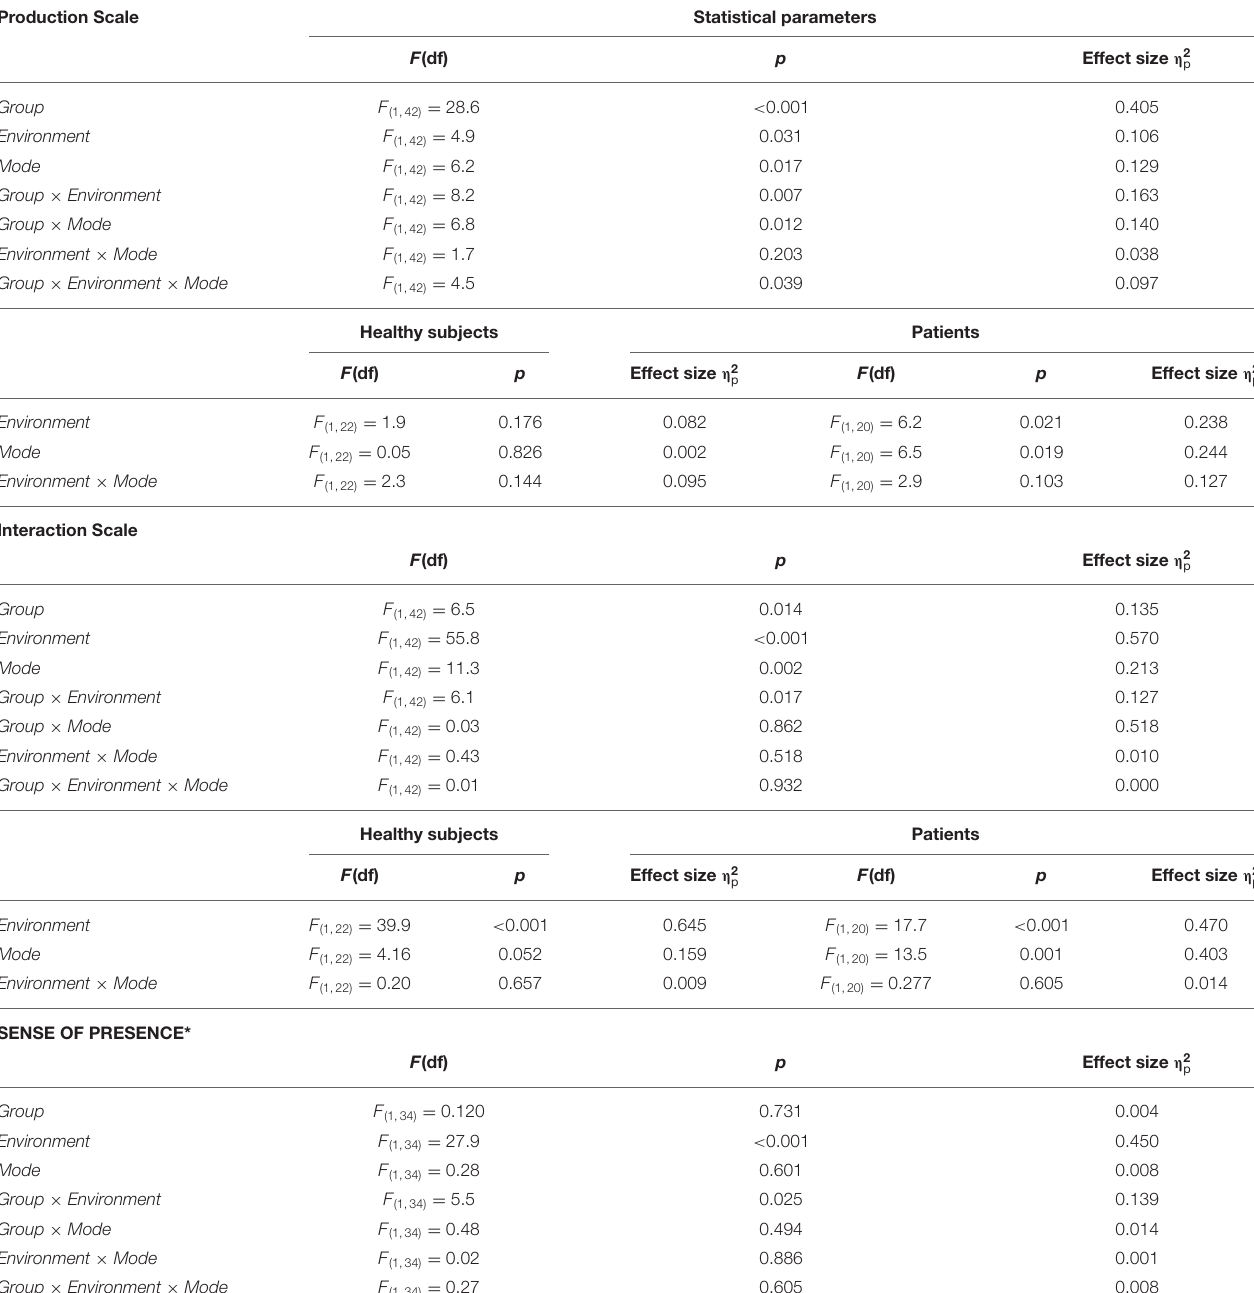
TABLE 3 | ANOVA summary for production scale, interaction scale and sense of